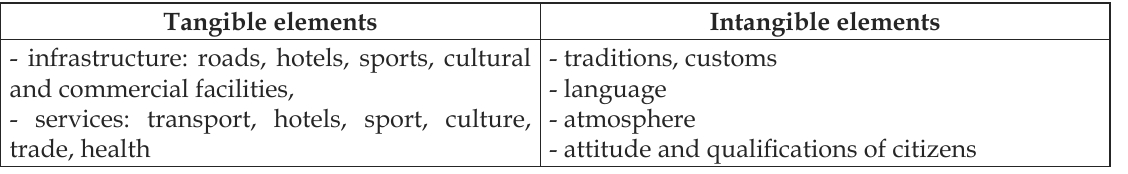
Tab. 1. Elements of tourism